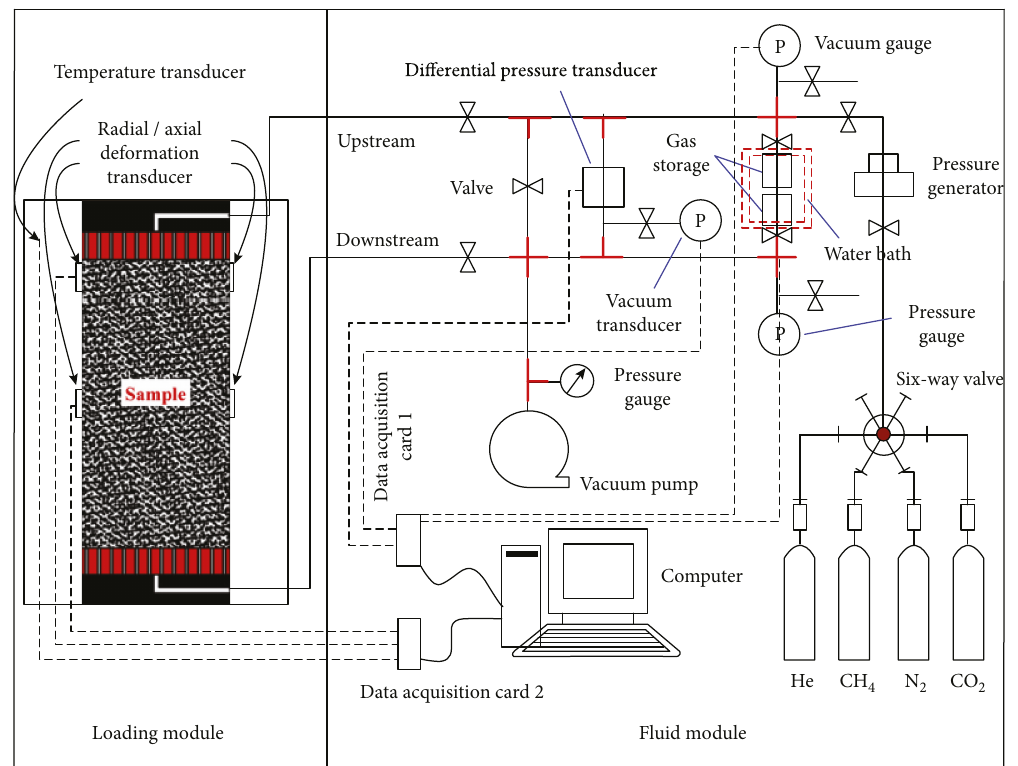
Figure 5: Schematic diagram of the experimental apparatus using the transient pressure method modi fi ed after Chen et al.